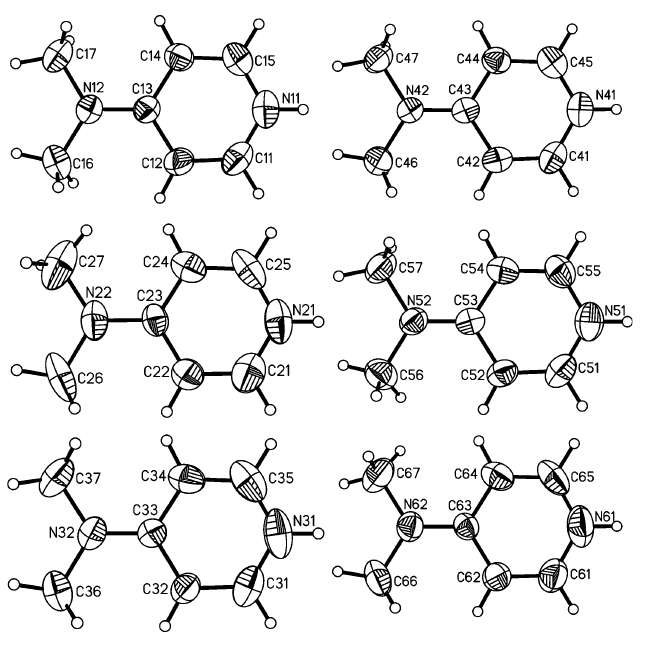
Figure 4 View of the six crystallographically independent 4-(dimethylamino)- pyridinium cations in 2 , with atomic labelling and displacement ellipsoids drawn at the 50% probability level.